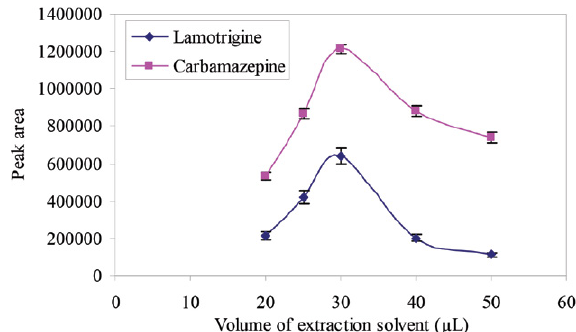
Figure 4. Effect of volume of extraction solvent on the extraction efficiency, Extraction conditions: extraction solvent: [C8MIM]